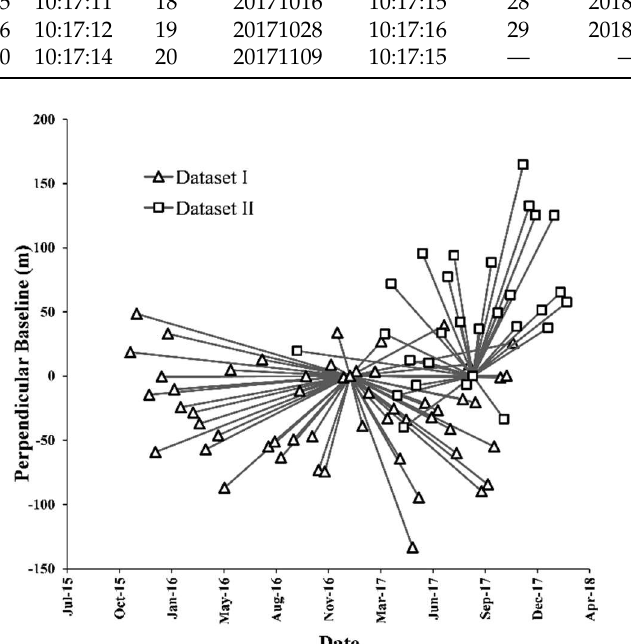
Figure 3. Interferometric combination of the two datasets and their perpendicular baselines.